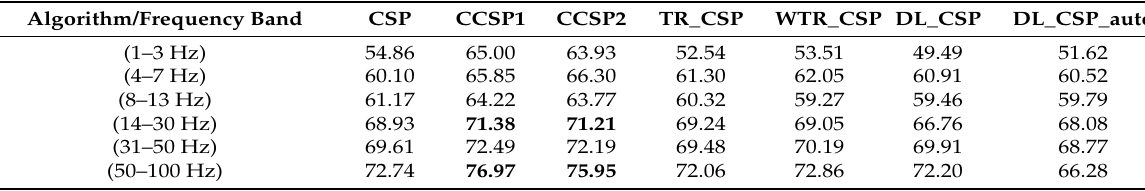
Table 3. Mean classification accuracies using conventional and regularized CSP algorithms for all the considered frequency bands. CCSP—composite CSP; TR_CSP—CSP with Tikhonov regularization; WTR_CSP—CSP with weighted Tikhonov regularization; DL_CSP—CSP with diagonal loading using cross validation.